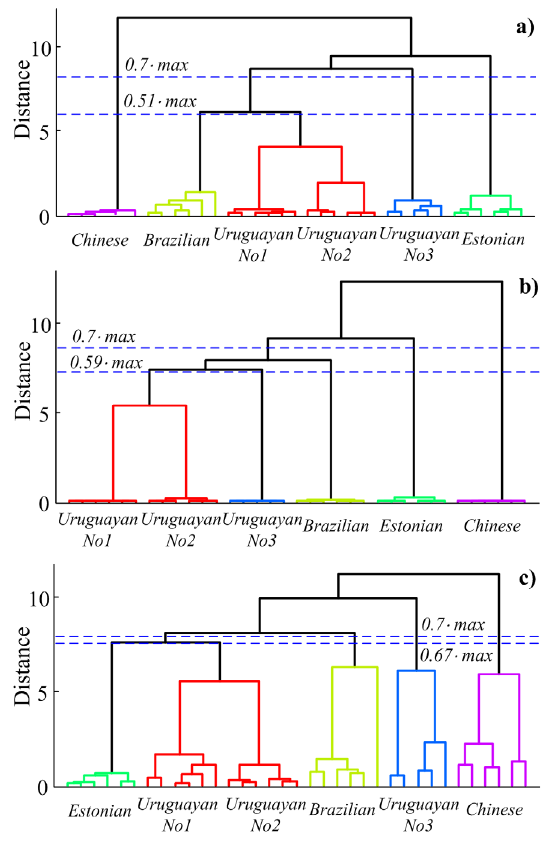
Figure 2. Dendrograms of hierarchical cluster analysis using different data pre-processing techniques (a – no data pre-processing, b – inverse data pre-processing, c – logarithmic data